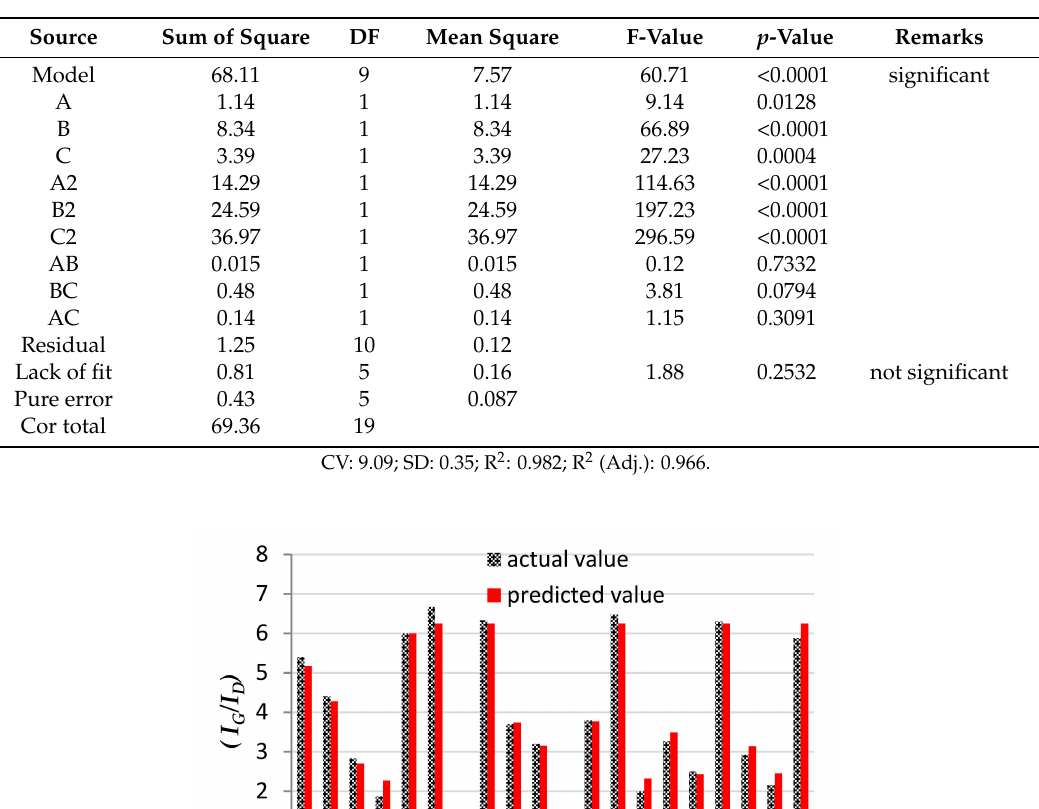
Table 4. Analysis of variance (ANOVA) for the response surface quadratic model.